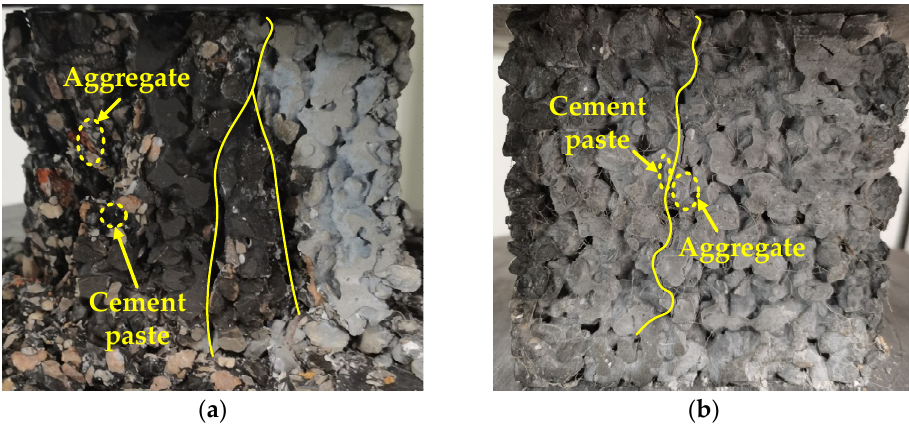
Figure 18. The failure of the specimen: ( a ) sample without basalt fiber and ( b ) sample with basalt